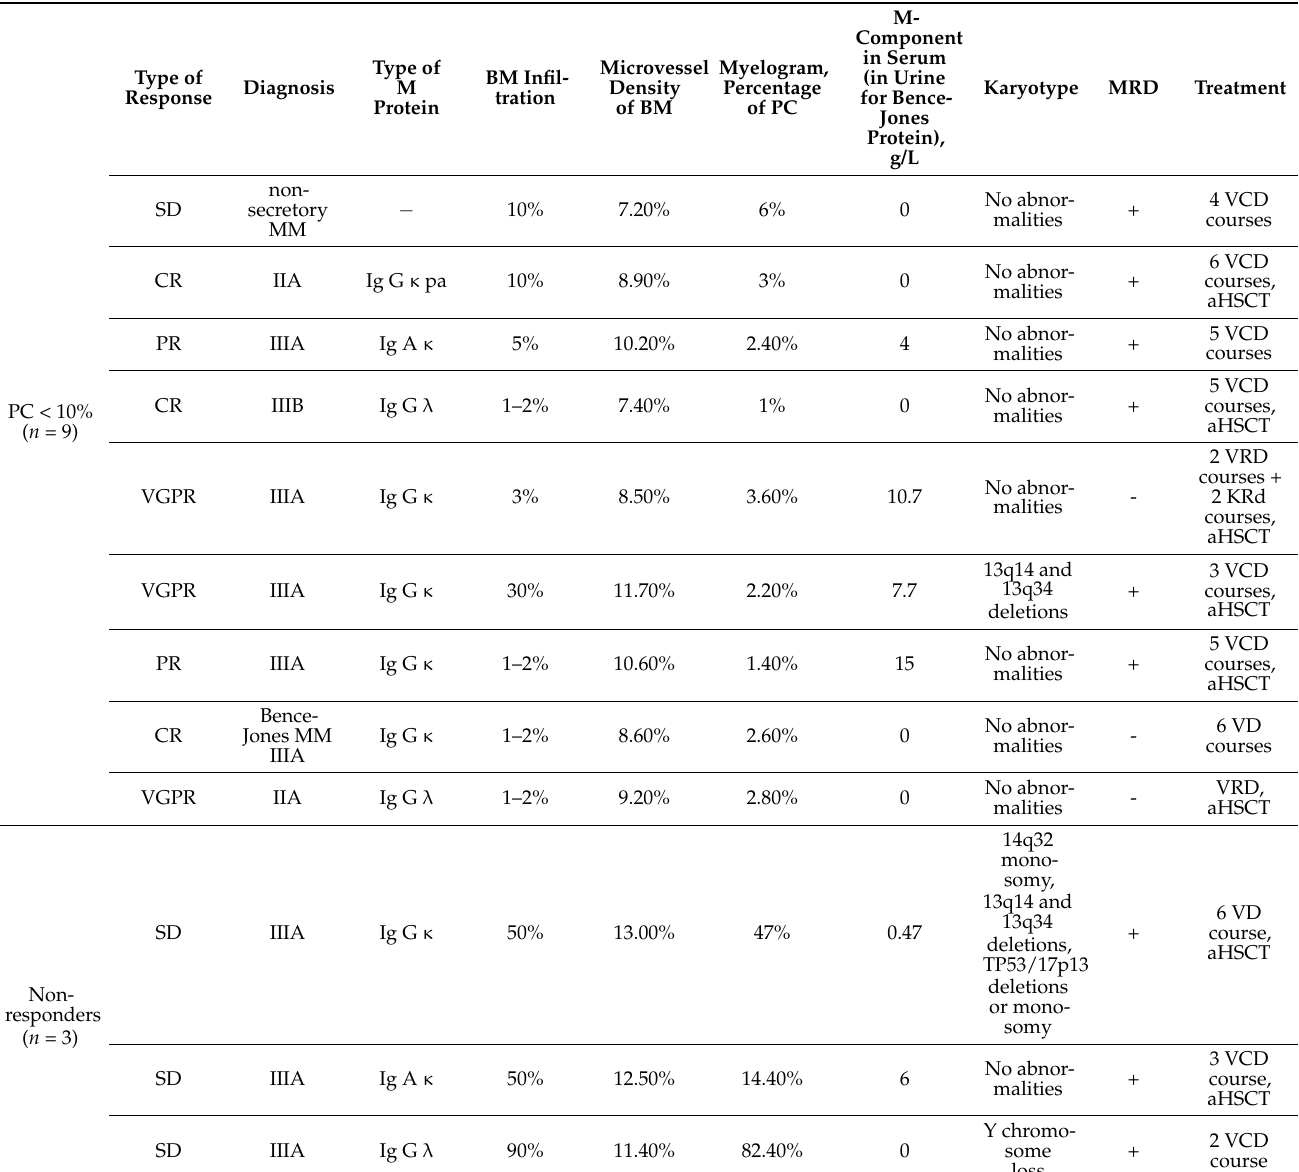
Table 1. Information about the patients enrolled in the